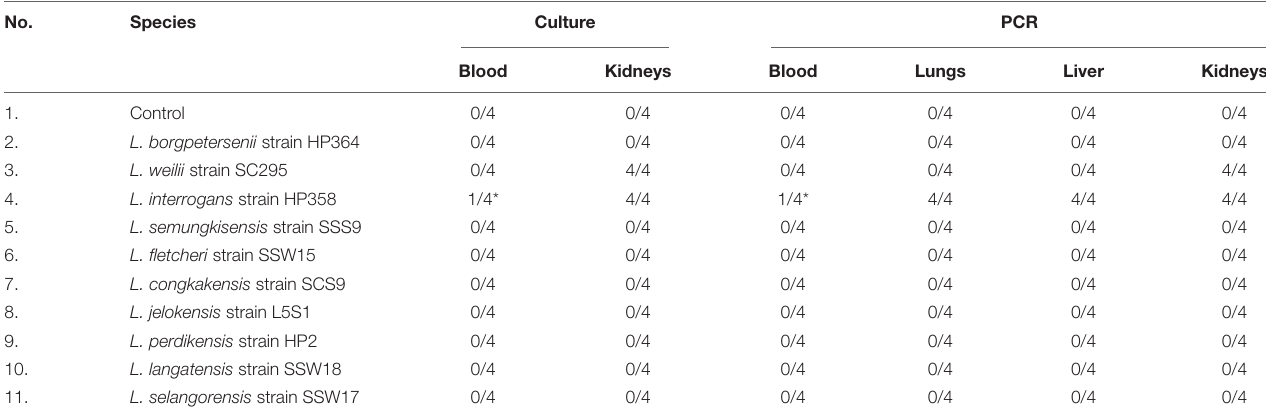
TABLE 3 | Recovery and detection of leptospires in blood and